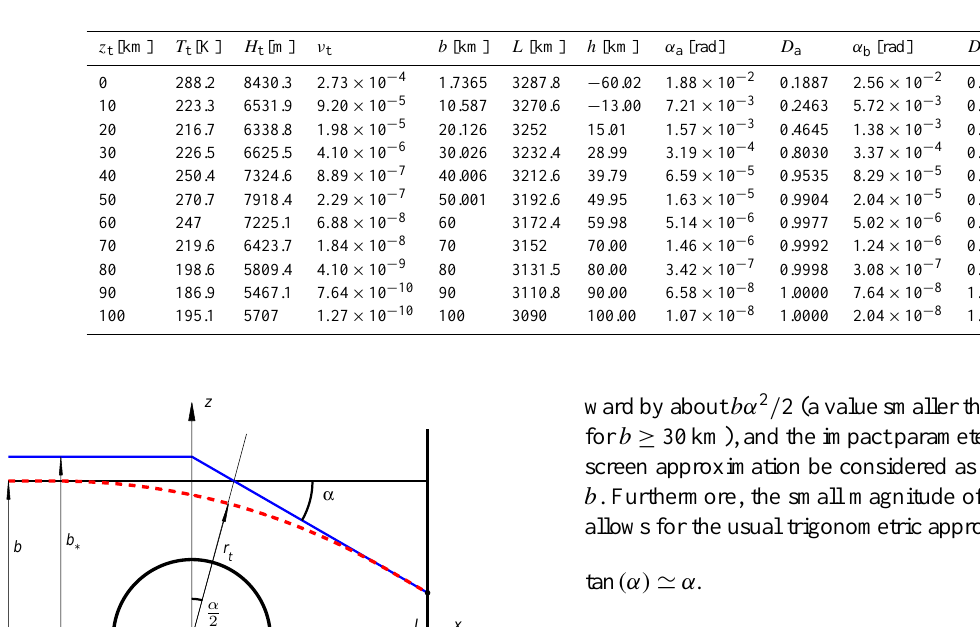
Table 1. Refraction parameters for a standard atmosphere: z t , T t , H t and ν t respectively refer to local tangent altitude, temperature, scale height and refractivity; b is the impact parameter, L the distance to the limb (satellite to phase screen), h is the unrefracted impact parameter; α a , D a , α b and D b are the refraction angles and the dilution factors computed by means of formula Eq. (9) (a) or by numerical ray tracing (b).